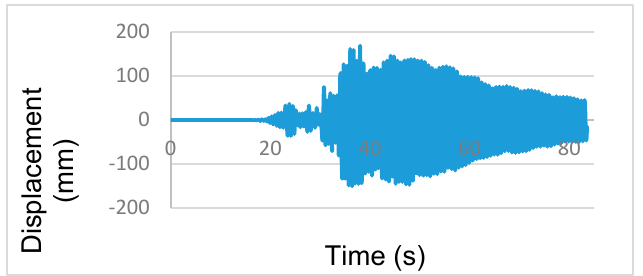
Figure 32. Time history analysis (Van earthquake) (max = 169.64 mm).